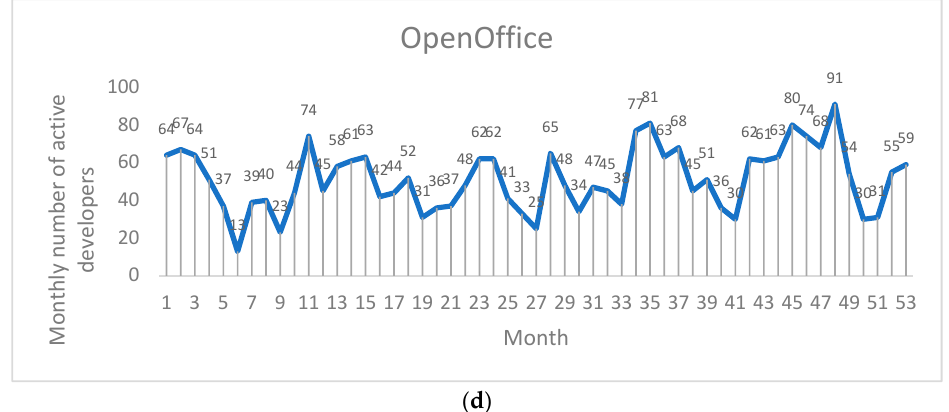
Figure 2. The statistics of the average number of different developers participating in each of the four datasets per month. ( a ) Mozilla; ( b ) Eclipse; ( c ) Netbeans; ( d ) OpenOffice. Table 1. Statistics of collected bug